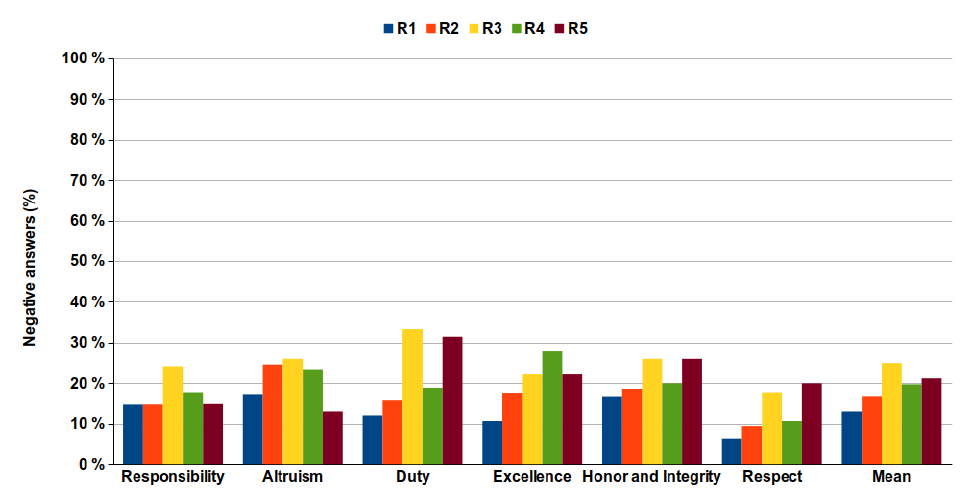
Figure 3. Percentage of negative responses by category and year of residence.